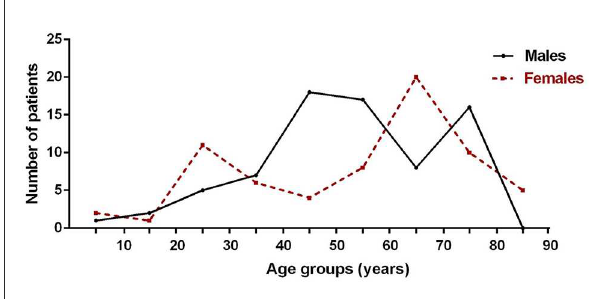
FIGURE3 Presence of MG by age of onset and sex ( n = 118).